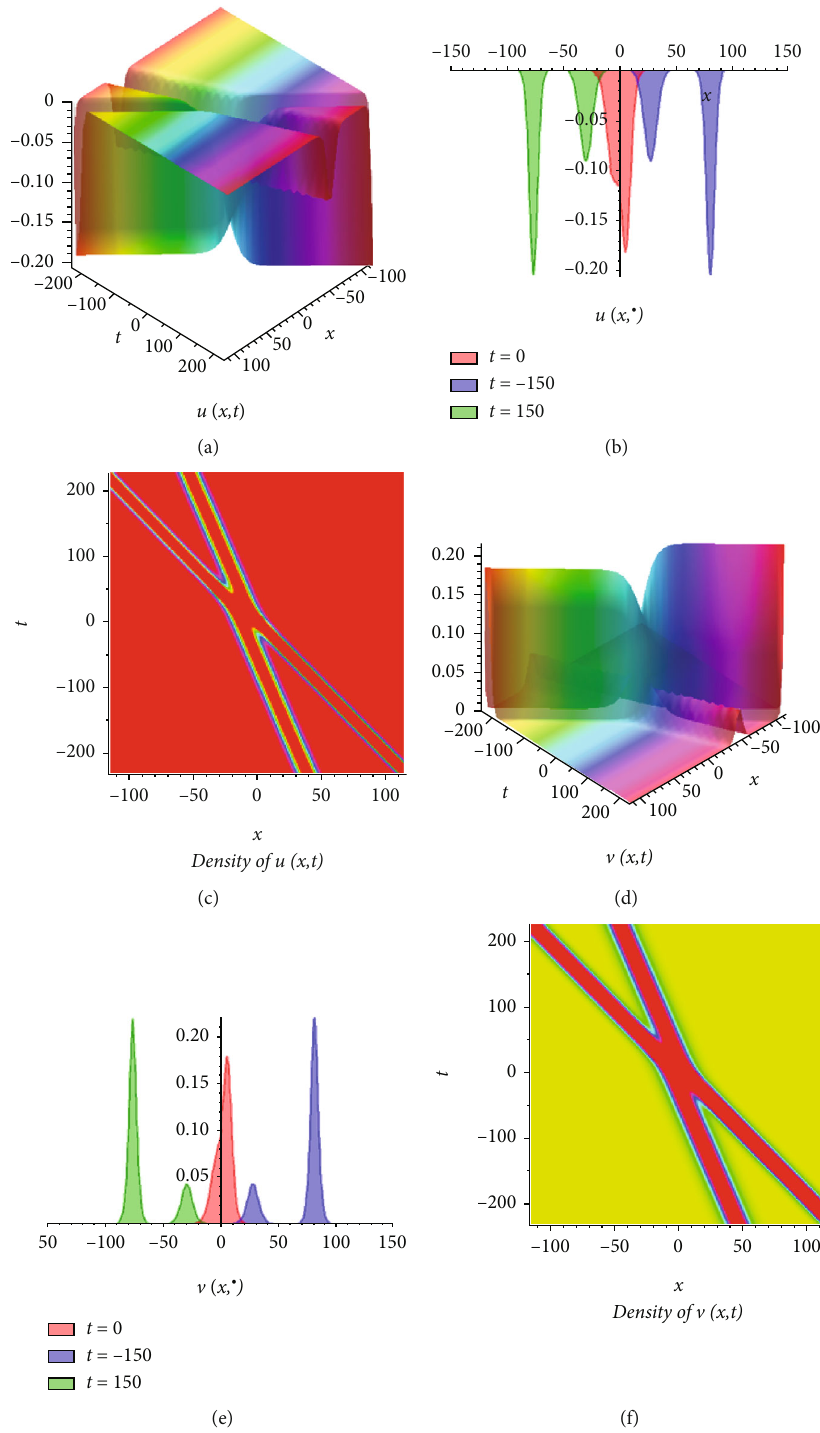
= 1/2, k = 1/3, α = 1 , respectively. (b, e) Soliton 1 2